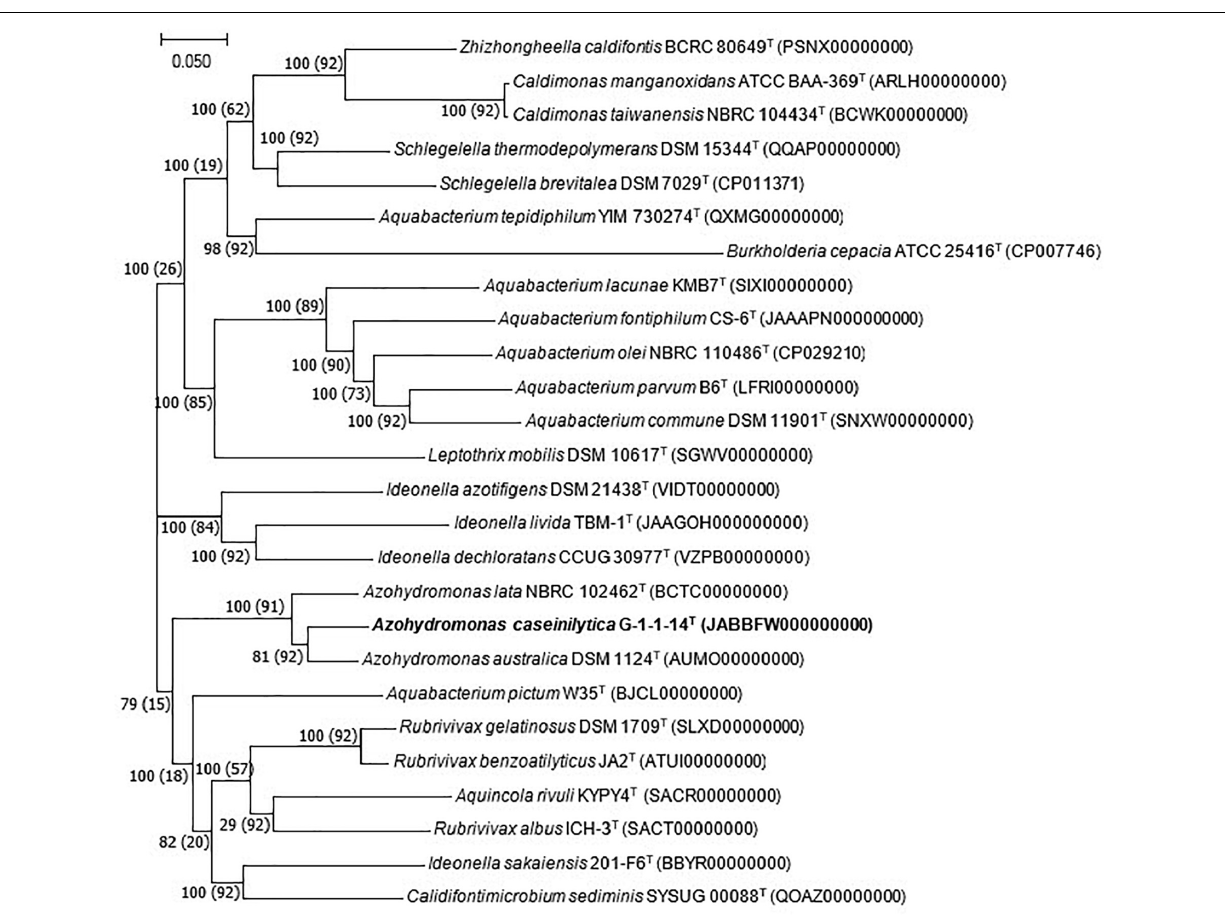
Frontiers in Microbiology |